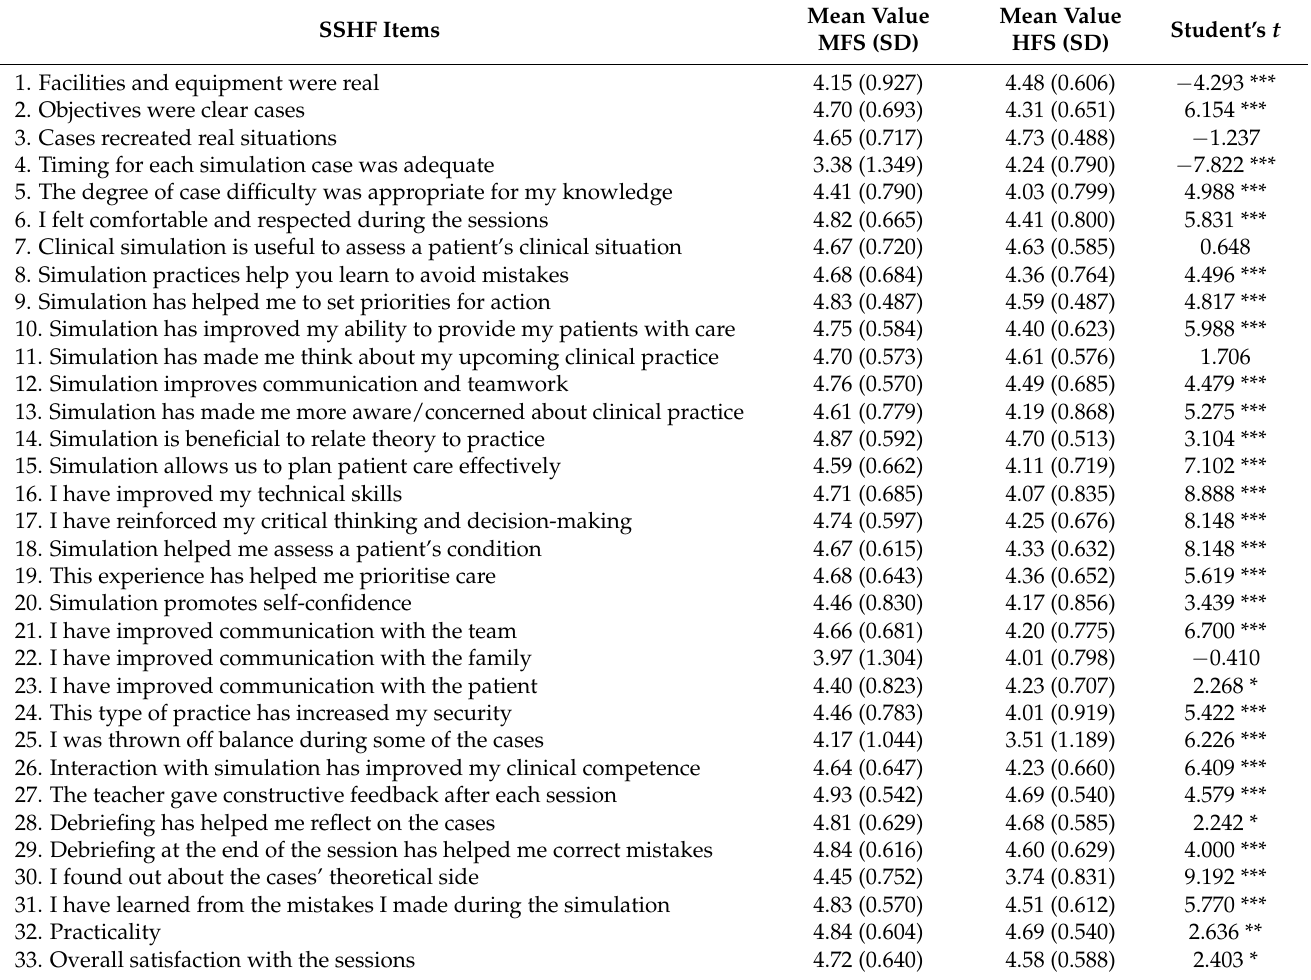
Table A1. Mean differences test of SSHF items by type of simulation (MFS and HFS).